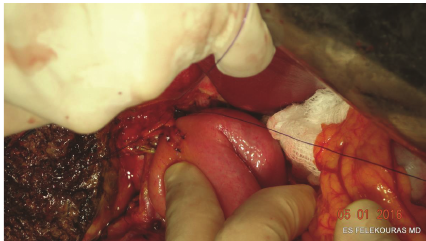
Figure 2: Construction of the posterior wall of the anastomosis. The jejunal limb is gently pushed down to the hepatic duct and the sutures are tied with the knots lying on the outside of the anas- tomosis.